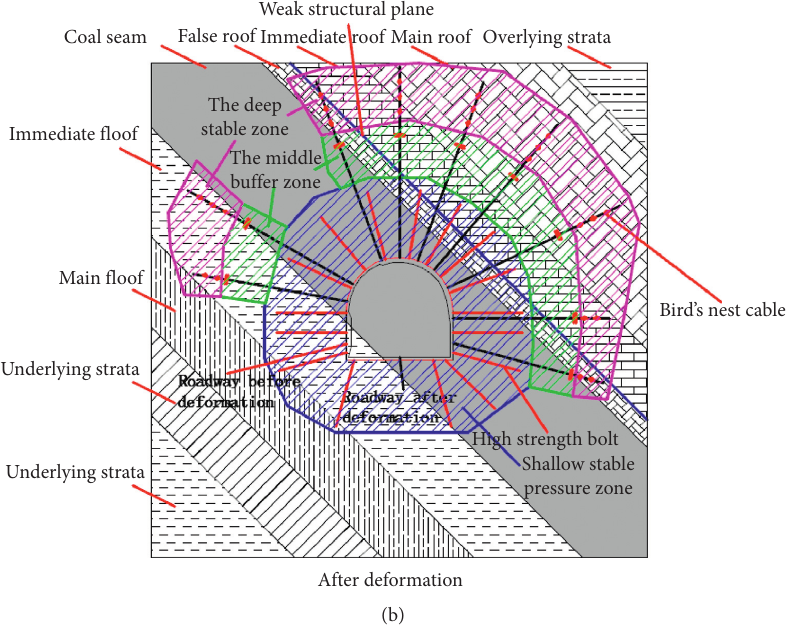
Bottom bolt: the bottom bolt is arranged in an asymmetric way. The row spacing between the bottom anchor bolts on the nonmining side is 500 mm × 800 mm, three in each row (one on the mining side and two on the nonmining side). The horizontal distance between the anchor bolts on both sides near the roadway side and the roadway side is 300 mm, and the inclination is 15 ° . The anchor rod on the nonmining side is 45 ° . The anchoring method and length of anchor bolt are consistent with those of top anchor bolt.